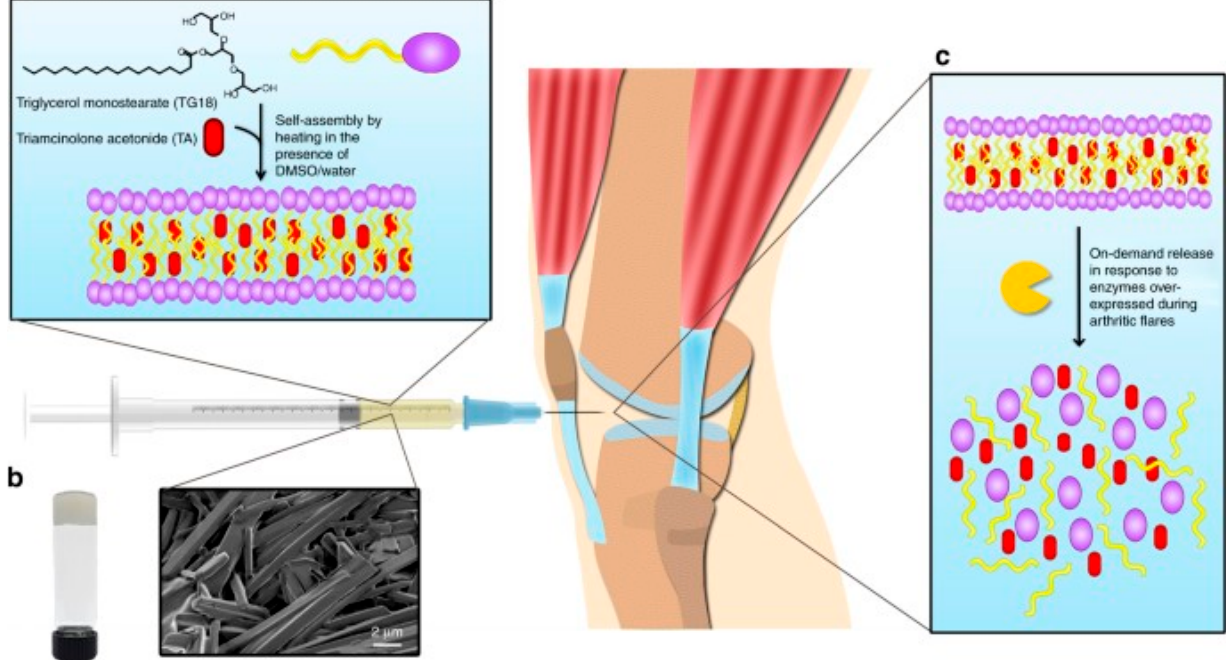
Figure 7. The biosensing triglycerol monostearate (TG-18) hydrogel releases the encapsulated drug (triamcinolone acetonide (TA) in response to enzymes upregulated during arthritis flares. ( a ). self- assembly of TG-18 to form hydrogel and encapsulation of TA; ( b ). scanning electron microscopy of TA-loaded TG-18 hydrogels; ( c ). disassembly of TG-18 hydrogel in response to flare-associated enzymes. The injectable hydrogel can be administered to the inflamed joints by intra-articular injection. Reproduced from Joshi et al. [116] Open Access.